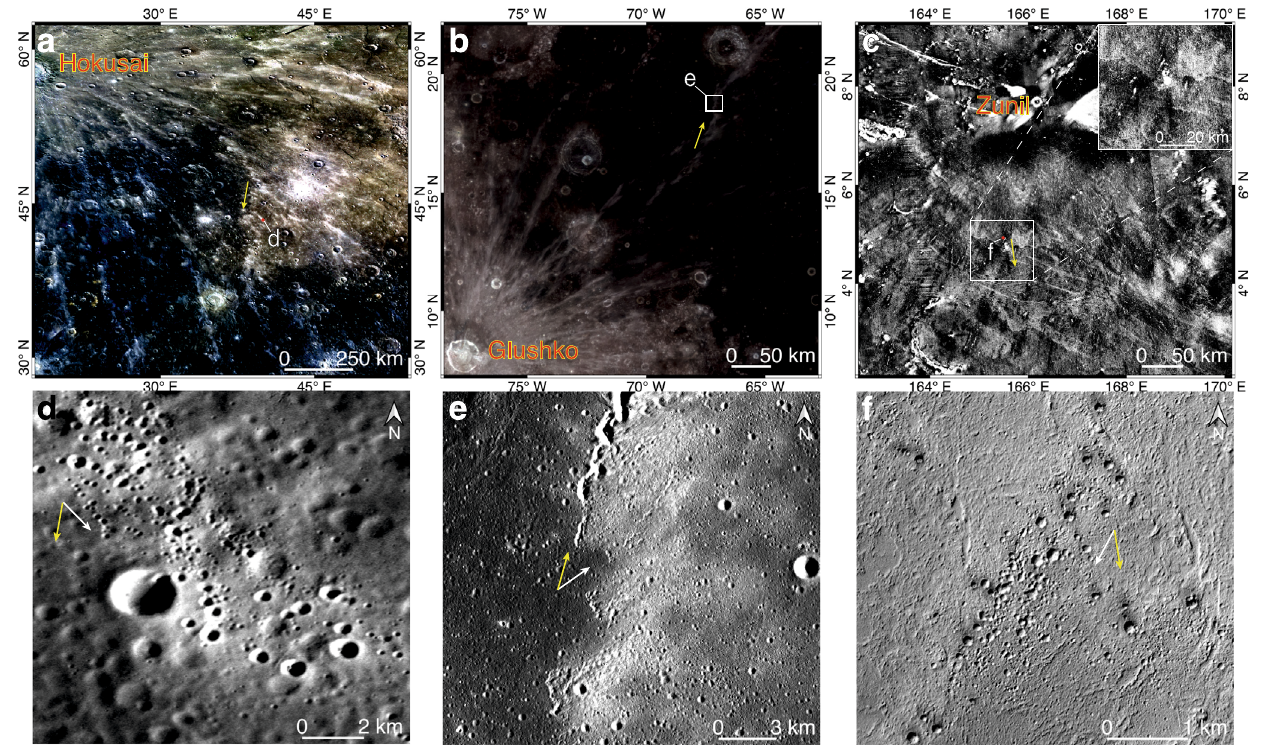
Fig. 2 | Non-radial rays on planetary bodies that are composed by discrete segments of radial rays. Yellow arrows denote regional extensions of the non- radialrays.Whitearrowsdenoteazimuthsoflandingofejectathatformedthelocal ray segments, which are determined based on both the asymmetric rim elevations of secondaries and the deposition directions of their ejecta. a , d A case of the